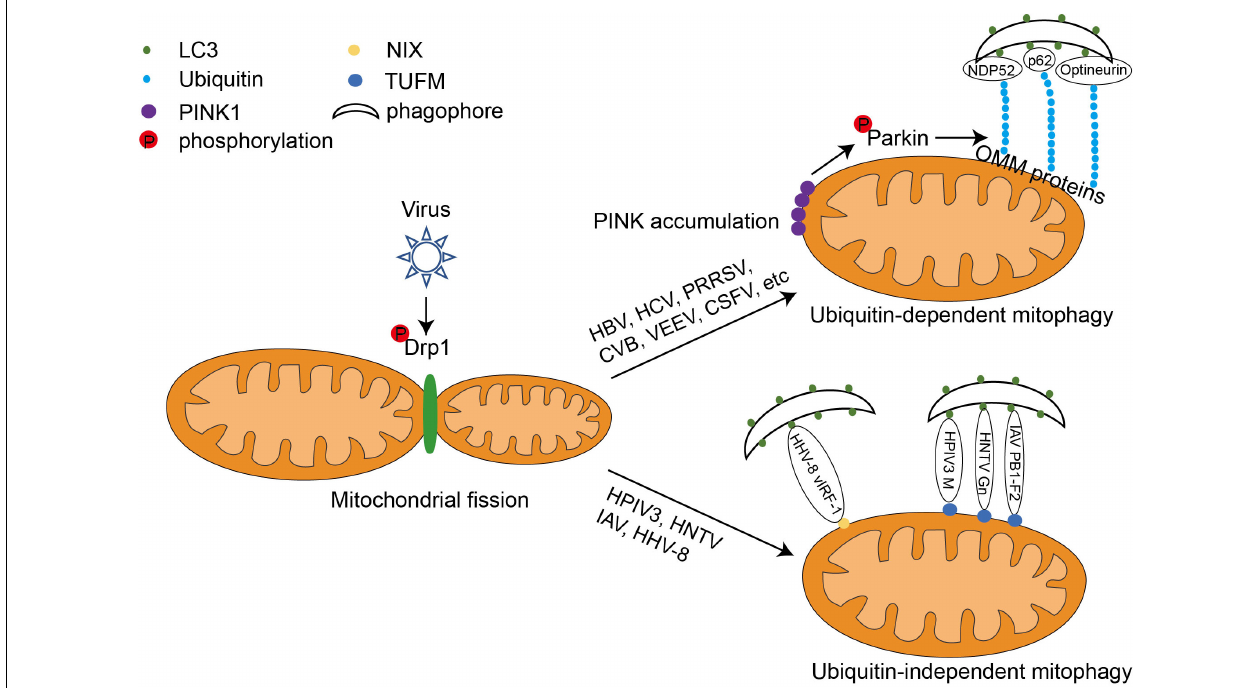
FIGURE 2 | The mechanism of viral-induced mitophagy. Following viral infection, the GTPase Drp1 wraps around certain sites of mitochondria, forcing them to divide. This causes the mitochondria to separate from the tubular structure. Some viruses such as HBV and HCV utilize ubiquitin-dependent mitophagy. They upregulate the expression of PINK1 and Parkin, leading to the aggregation of PINK1 on the OMM, recruitment of the E3 ligase Parkin, and Parkin activation via phosphorylation. Activated Parkin can ubiquitinate OMM proteins such as MFN1 and MFN2. The poly-ubiquitinated OMM proteins serve as binding sites for both mitophagy adaptors (optineurin, p62, and NDP52) and LC3. The mitochondria can then be wrapped around by autophagosome and degraded by autophagy. Other viruses, such as IAV, HPIV3, and HTNV, can induce mitophagy via interactions with both LC3 and the mitochondrial elongation factor, TUFM. Interestingly, the HHV-8-encoded viral protein vIRF-1 directly induces NIX-mediated mitophagy in host cells.